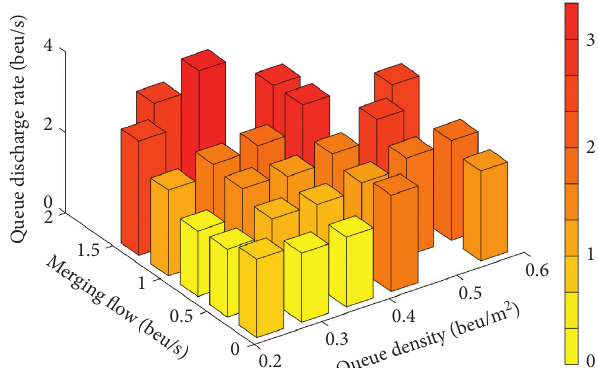
Figure 6: Queue discharge rate at different jam densities and merging flows, expressed in bicycle equivalent